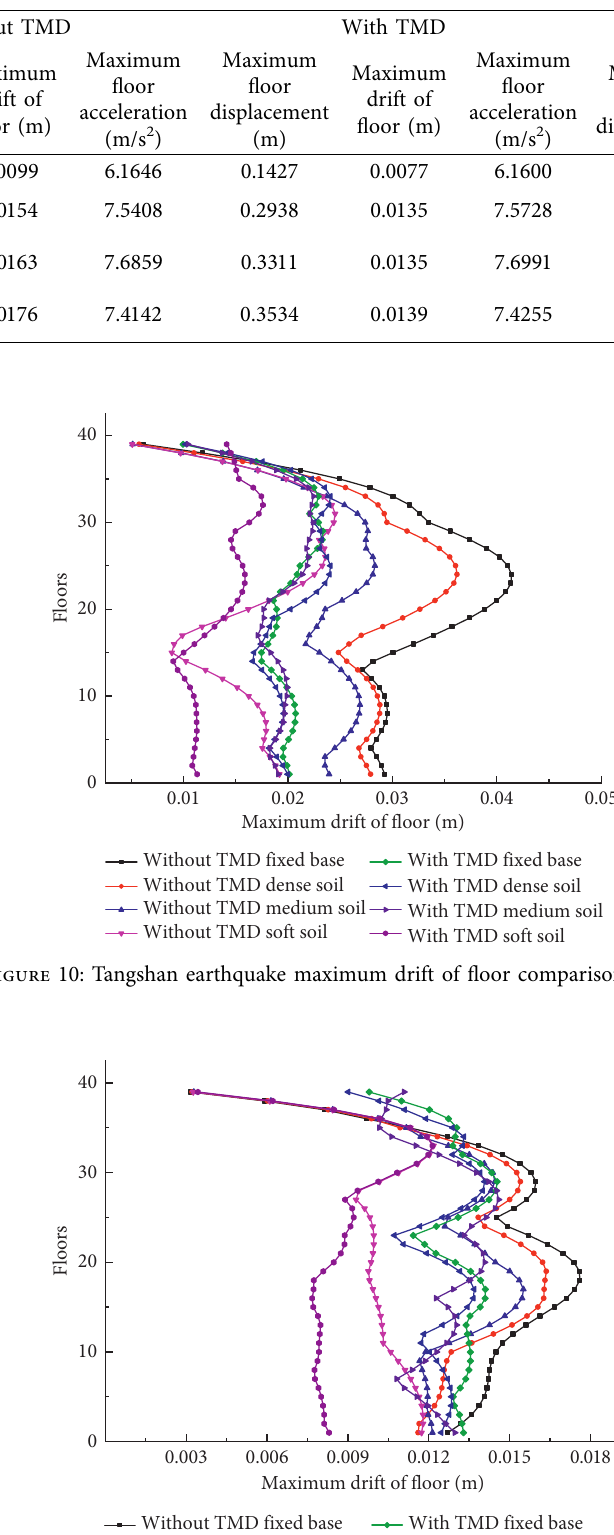
Table 8: Dynamic response to EL Centro wave with or without TMD.